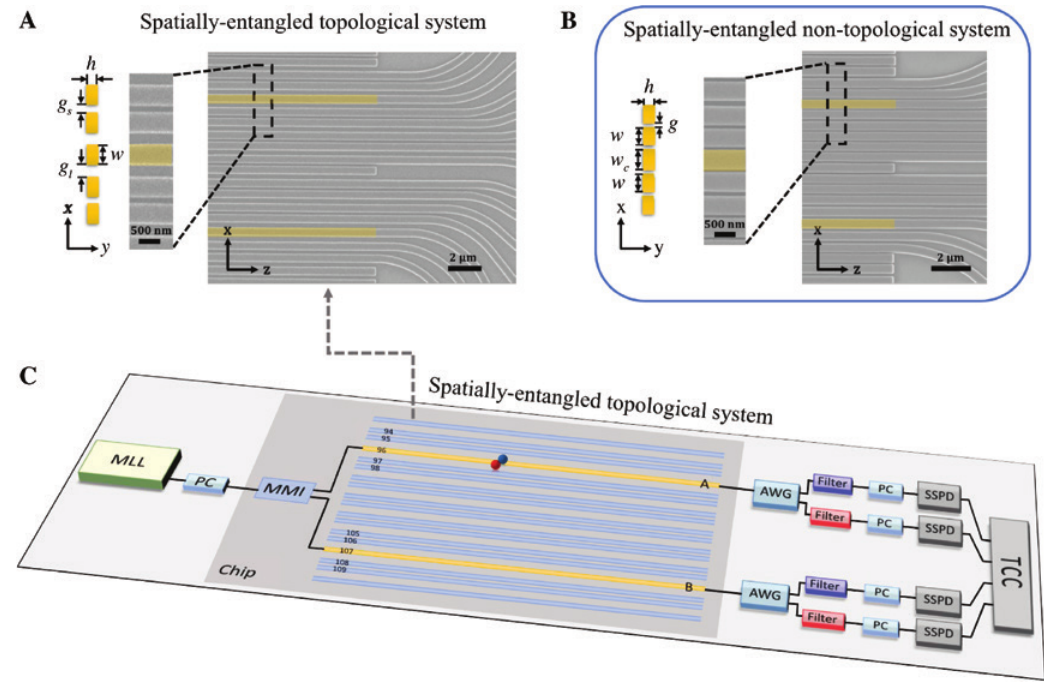
Figure 1: Experimental setup of our nanophotonic platform. (A) SEM image of the center waveguides of a fabricated lattice with two topological defects. The center waveguide of each long-long defect is highlighted in yellow. (B) SEM image of the center waveguides of a non-topological system with two trivial defects, where localization is provided by index-guiding. The two wider waveguides are highlighted in yellow. (C) Schematic of the experimental setup. Mode-locked laser (MLL), polarization controllers (PCs), on-chip multimode interferometer (MMI), lattice of coupled silicon waveguides with two long- long defects supporting topological modes localized around waveguides 96 and 107, arrayed waveguide gratings (AWGs), tunable filters, superconducting nanowire single-photon detectors (SSPDs), and time correlation circuit